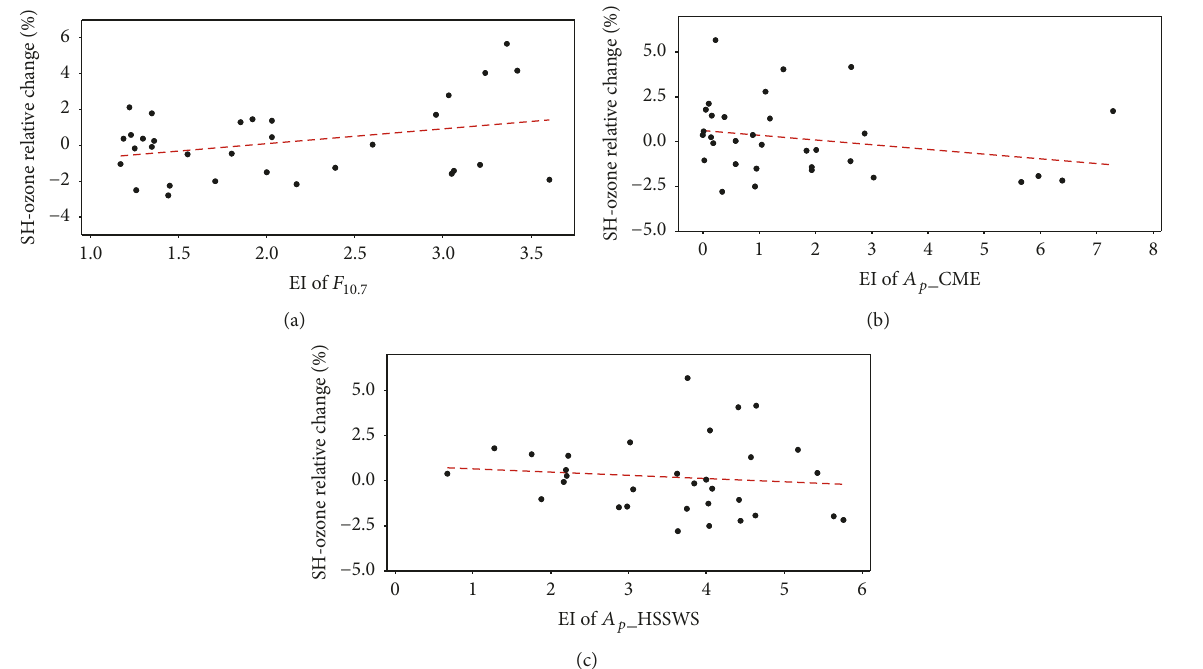
Figure 3: The energy index (EI) of 𝐹 10.7 (a), CME (b), and HSSWS (c) versus the polar ozone relative anomalies in the SH. The red dash lines are linear fittings of the